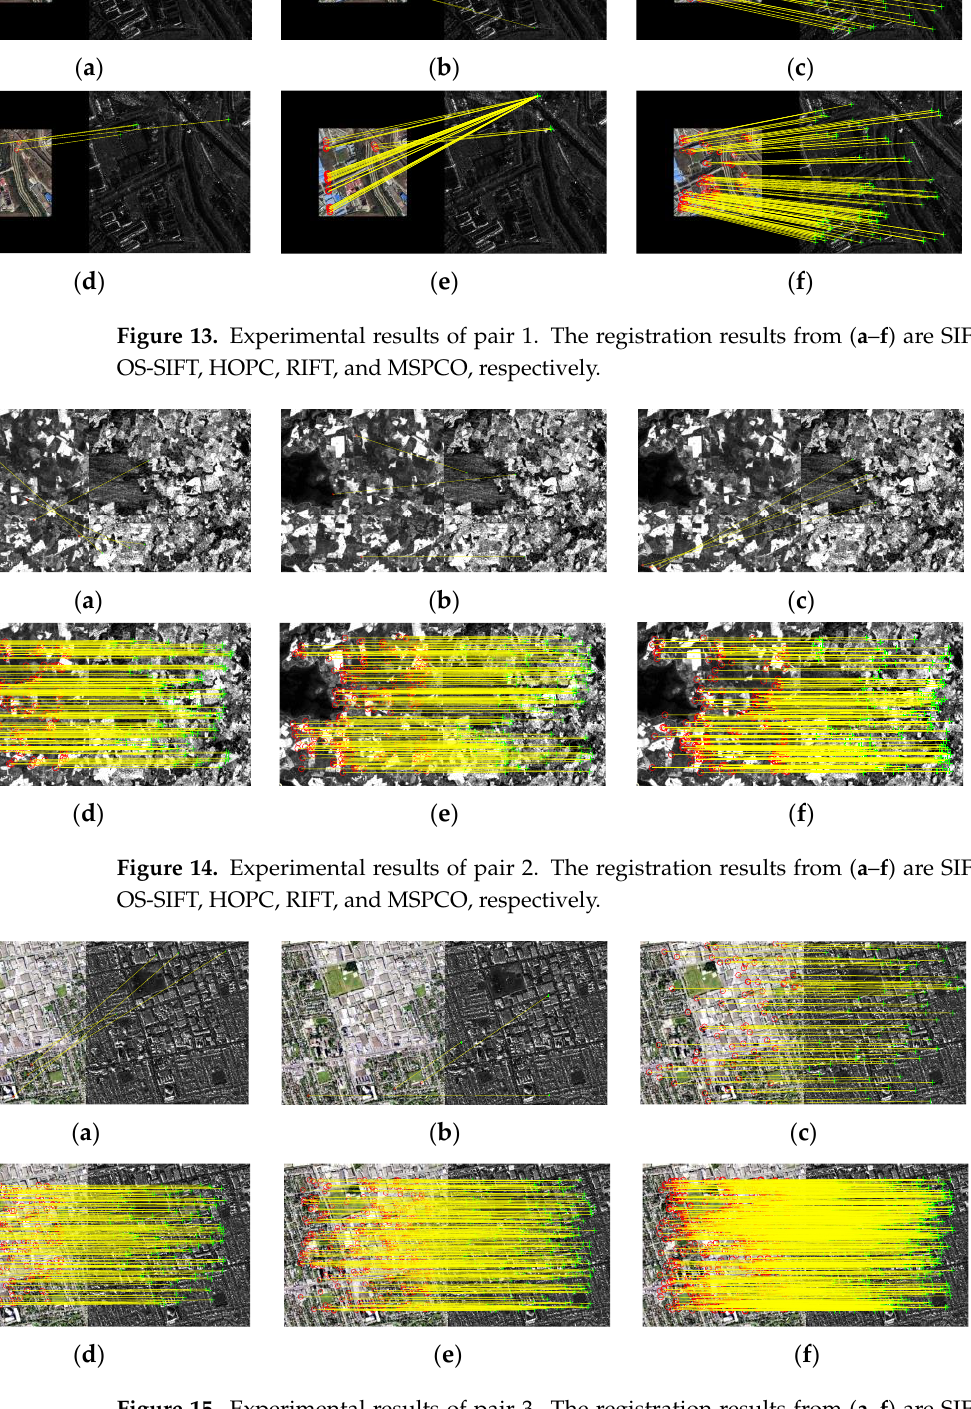
( f ) Figure 16. Experimental results of pair 4. The registration results from ( a ) to ( f ) are SIFT, SAR-SIFT, OS-SIFT, HOPC, RIFT, and MSPCO, respectively. ( a ) ( f ) Figure 17. Experimental results of pair 5. The registration results from ( a ) to ( f ) are SIFT, SAR-SIFT, OS-SIFT, HOPC, RIFT, and MSPCO, respectively. ( a ) ( b ) ( c )